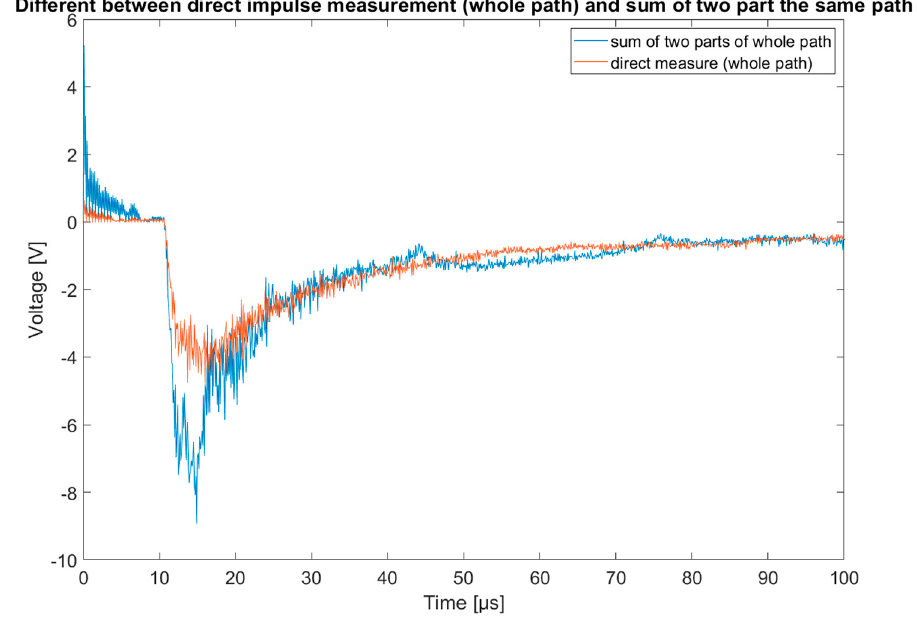
Figure 12. Measured overvoltage and simulated for the same circuits (two blocks). Input in points 1, 2 (motor coil) and output in voltage stabilizer (point 12).